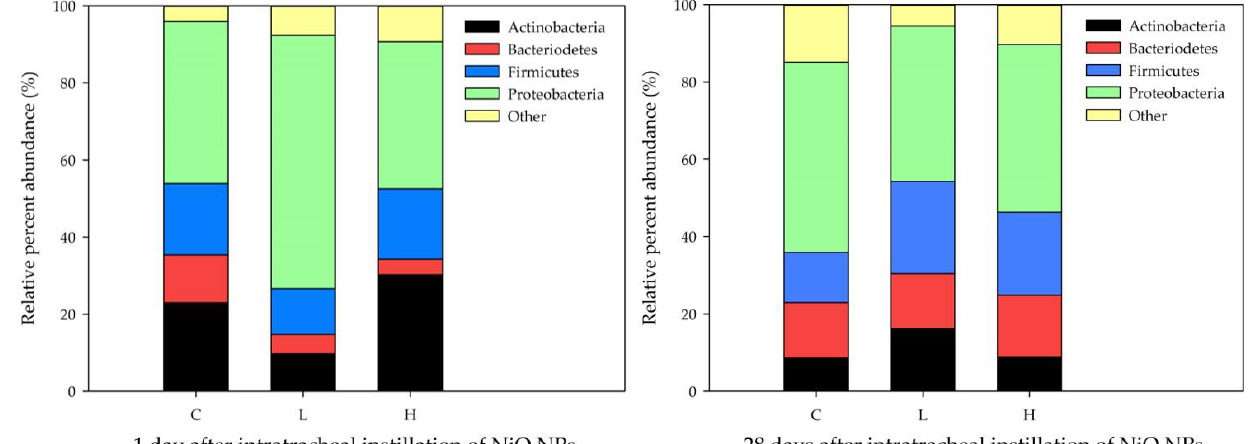
Figure 7. Bacterial taxonomic composition analysis after exposure to nickel oxide nanoparticles (NiO NPs). Bacterial taxonomic assignment was at the phylum level and samples were compared according to NiO NPs concentrations at 1 day and 4 weeks after instillation. NiO NPs induced the change in lung microbial composition in rats at 1 day after instillation. C: control group; L: low-dose group (50 cm 2 /rat); H: high-dose group (150 cm 2 /rat).